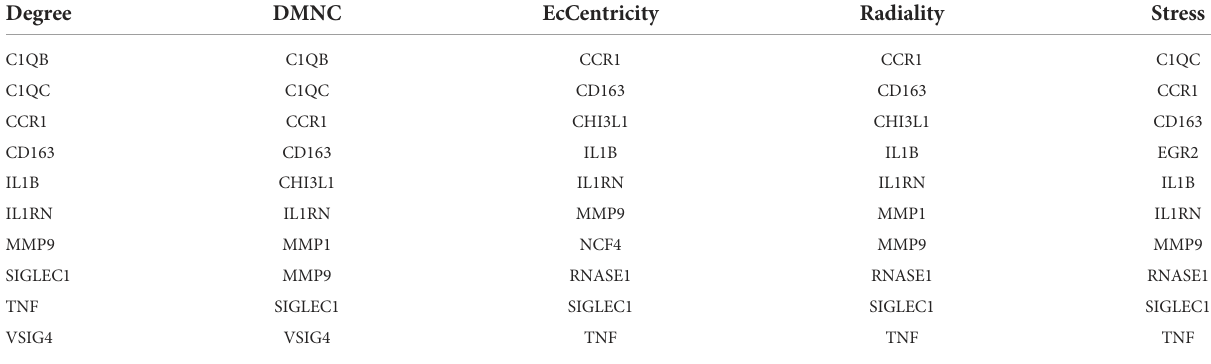
TABLE 2 The top 10 HGs as ranked in CytoHubba.